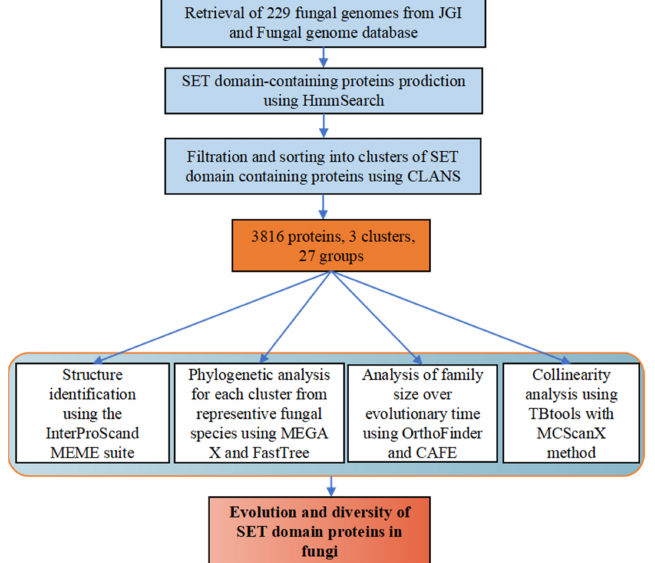
Figure 1. Pipeline schematic of the SET domain proteins in fungi. Predicted protein sets for a given species are fed into the pipeline. In the first step, the protein sets are searched with the SET-domain (PF00856) HMM profile. Next, candidate SET-domain genes are filtered and sorted into families by CLANS program. Then those identified 3816 SET-domain genes were subsequently analyzed with structure analyses, phylogenetic analysis, gene family size analysis, and collinearity analysis.